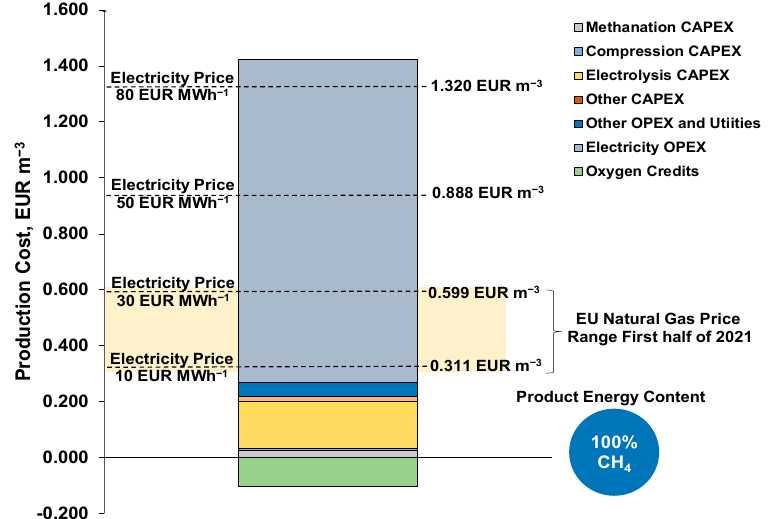
Figure 10. Methane production cost breakdown and effect of electricity price of the NG case.